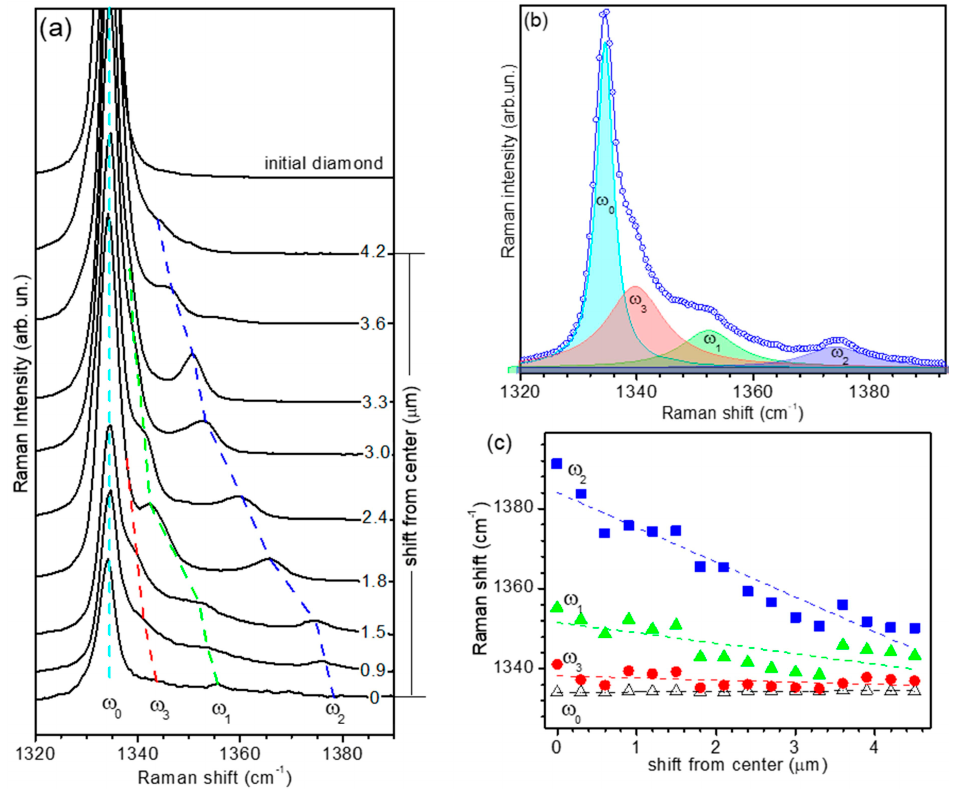
Figure 5. ( a ) Set of Raman spectra obtained by lateral scanning across the indent in the diamond from centre to edge. ( b ) Example of decomposition of typical Raman spectra taken inside the indent. ( c ) Frequencies of Raman modes in dependence on the spatial position from the centre of the indent.